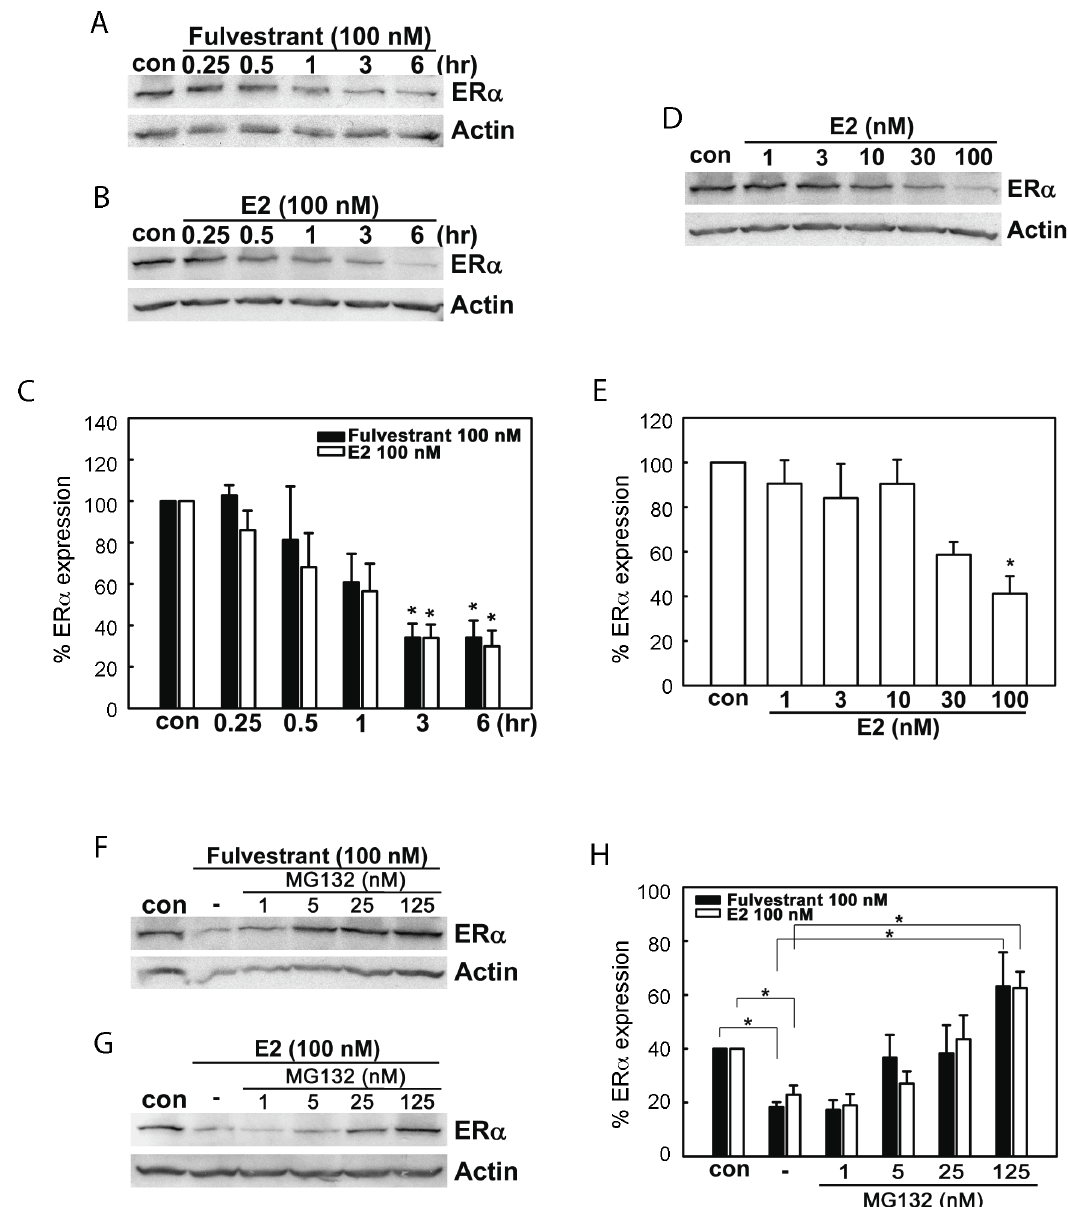
Figure 3. Both fulvestrant and 17 b -estradiol (E2) enhance proteasomal degradation of ER a protein in MCF-7 cells. (A–C) Fulvestrant (A) and E2 (B) caused time-dependent reduction in ER a protein expression: Western blotting. Intensities of ER a protein bands were determined by densitometry (C, mean 6 SEM of three independent experiments. Asterisks indicate statistical significance, p , 0.05 to vehicle control). (D, E) E2 dose- dependent reduction in ER a protein expression. Cells were exposed to varying concentrations of E2 for 6 hours and subjected to Western blotting analysis of ER a protein (D). Intensities of ER a protein bands were determined by densitometry (E, mean 6 SEM of three independent experiments. Asterisk indicates t-test significance p , 0.05 to vehicle control). (F–H), Pre-exposure to MG132 dose-dependently prevented reduction in ER a protein expression caused by fulvestrant (F) and E2 (G). Con, vehicle control (0.1% ethanol). Cells were exposed to varying concentrations of MG132 for 30 minutes and then exposed additionally to fulvestrant or E2 for 6 hours. Intensities of ER a protein bands were determined by densitometry (H, mean 6 SEM of three independent experiments. Asterisks indicate statistical significance, p , 0.05). doi:10.1371/journal.pone.0060889.g003 with pLKO.1 control virus did not significantly alter the action of CSK shRNA lentiviruses was slightly reduced from fulvestrant effect (Figs. 4A and 4B). To obtain more quantitative 37.45 6 1.48 ng/100 m g to 30.22 6 1.75 ng/100 m g (shRNA # 1) ER a protein data, we repeated this experiment but using ELISA and 39.55 6 0.65 ng/100 m g to 31.60 6 0.77 ng/100 m g (shRNA # 2) (Fig. 4C). Thus, agreeing with the Western blotting data, ER a (Fig. 4C). After exposure to fulvestrant for 6 hours, ER a protein in pLKO.1-infected control cells was reduced from 37.65 6 1.64 ng/ expression determined by ELISA was reduced to 33.6 6 6.1% of 100 m g total extractable cellular protein to 22.27 6 0.72 ng/ vehicle-exposed control after 6-hour exposure to 100 nM fulvestrant in pLKO.1-infected cells. In contrast, cells infected 100 m g. On the other hand, ER a expression in cells infected with